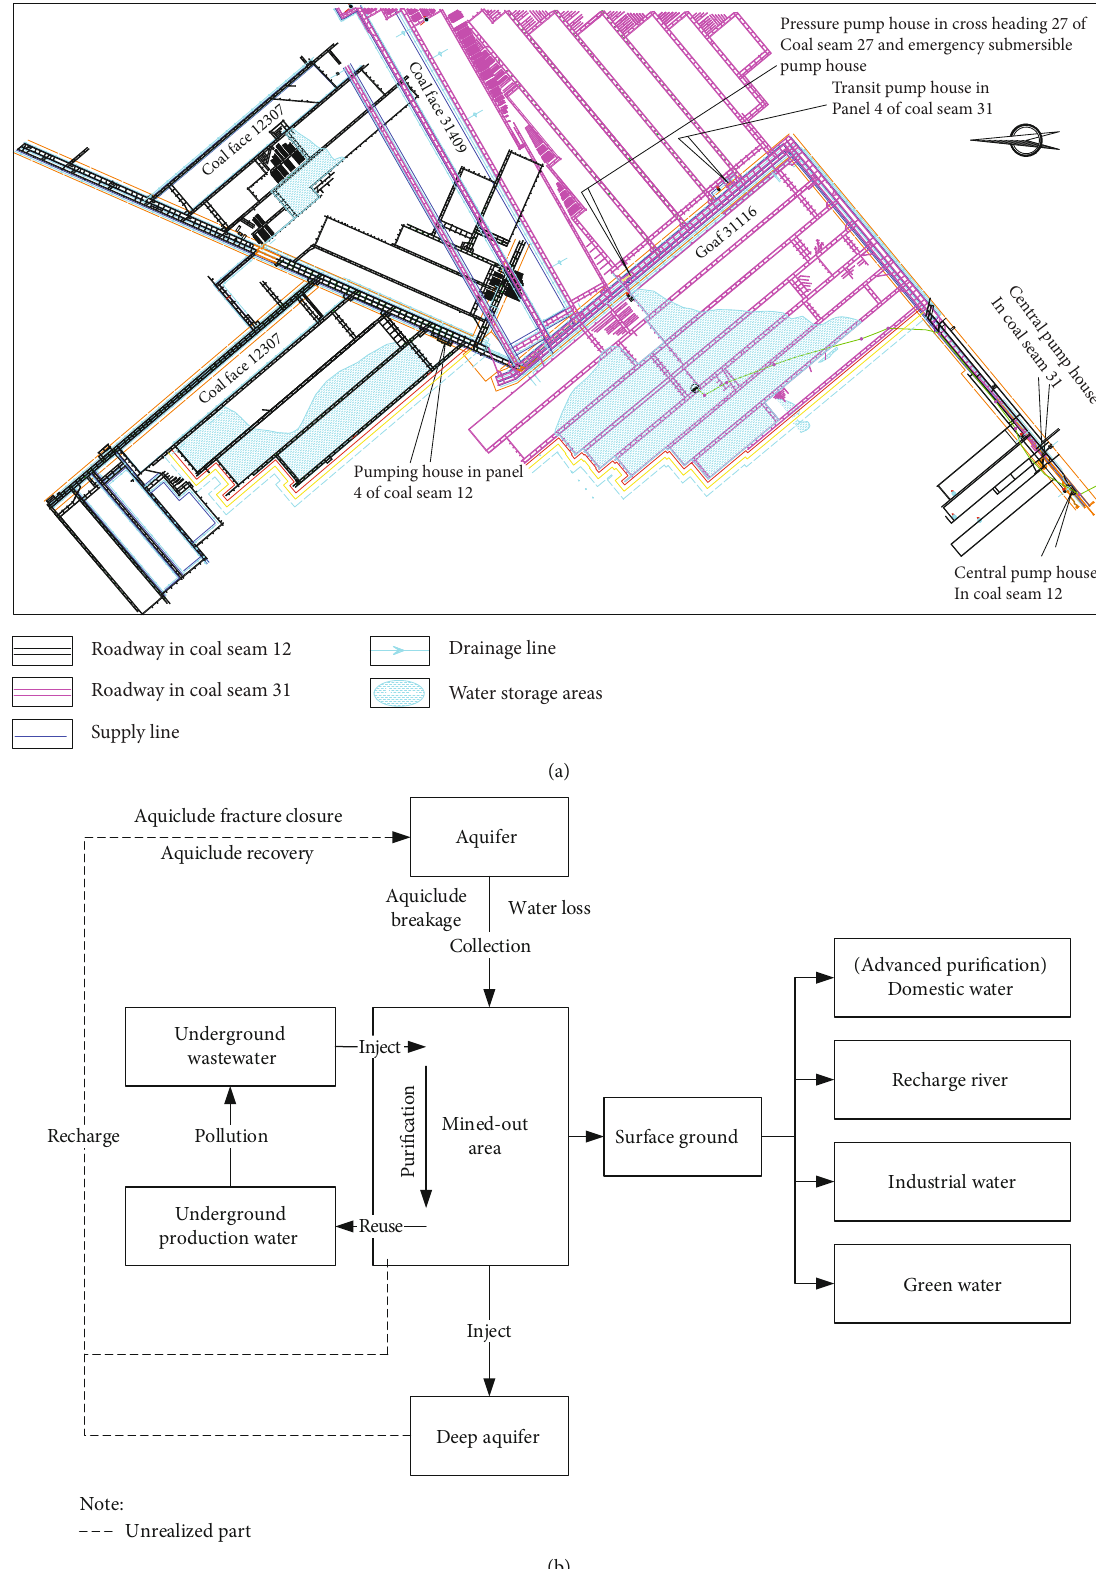
Figure 1: Layout and concept of goaf water